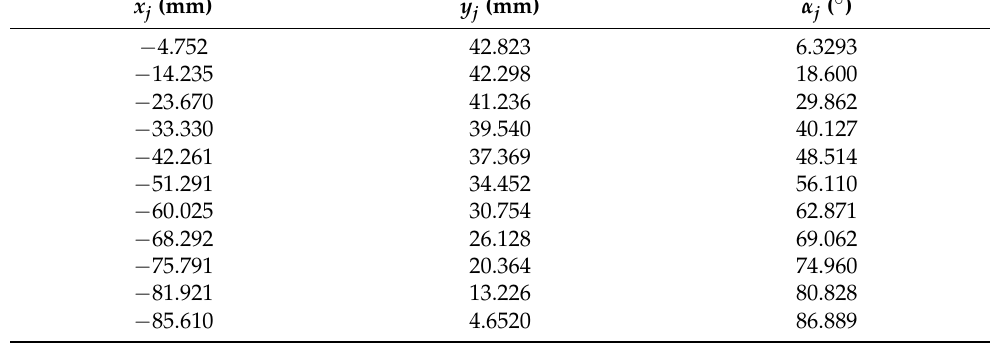
Table 1. Summary of data for building a CAD model of an ellipse wheel.